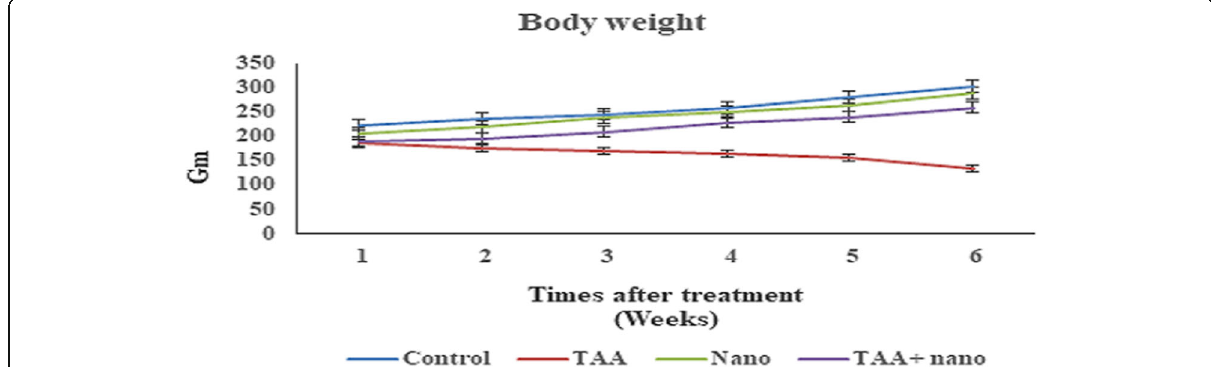
Fig. 3 The body weights before and after and the treatment with Ag-BSEPS in